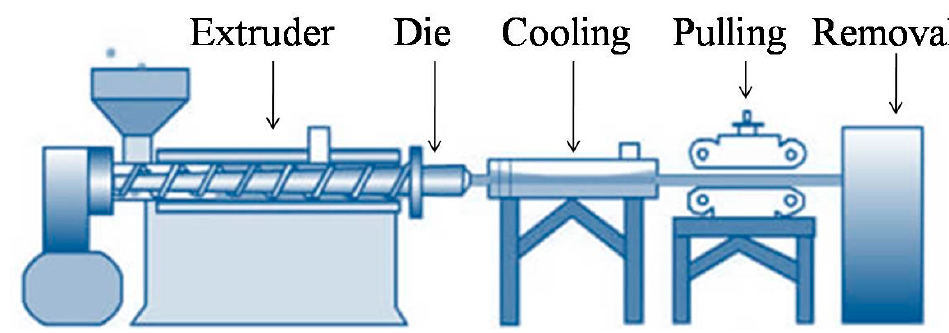
Figure 2. Film extrusion process.